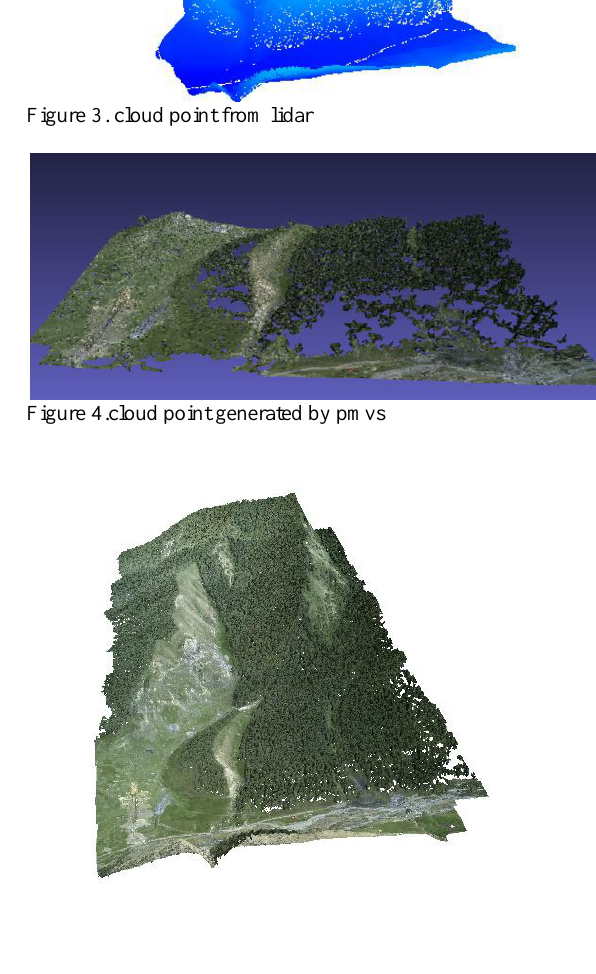
Figure 6 point cloud generated by